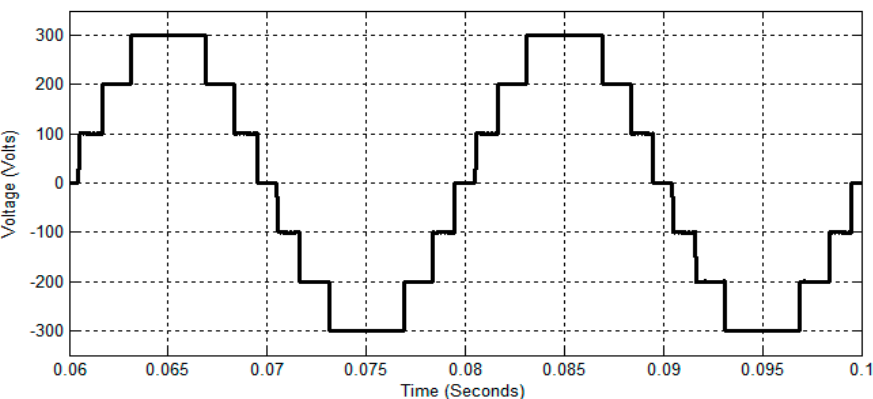
Figure 19. Inverter output across LGU using the SPWCAD technique.